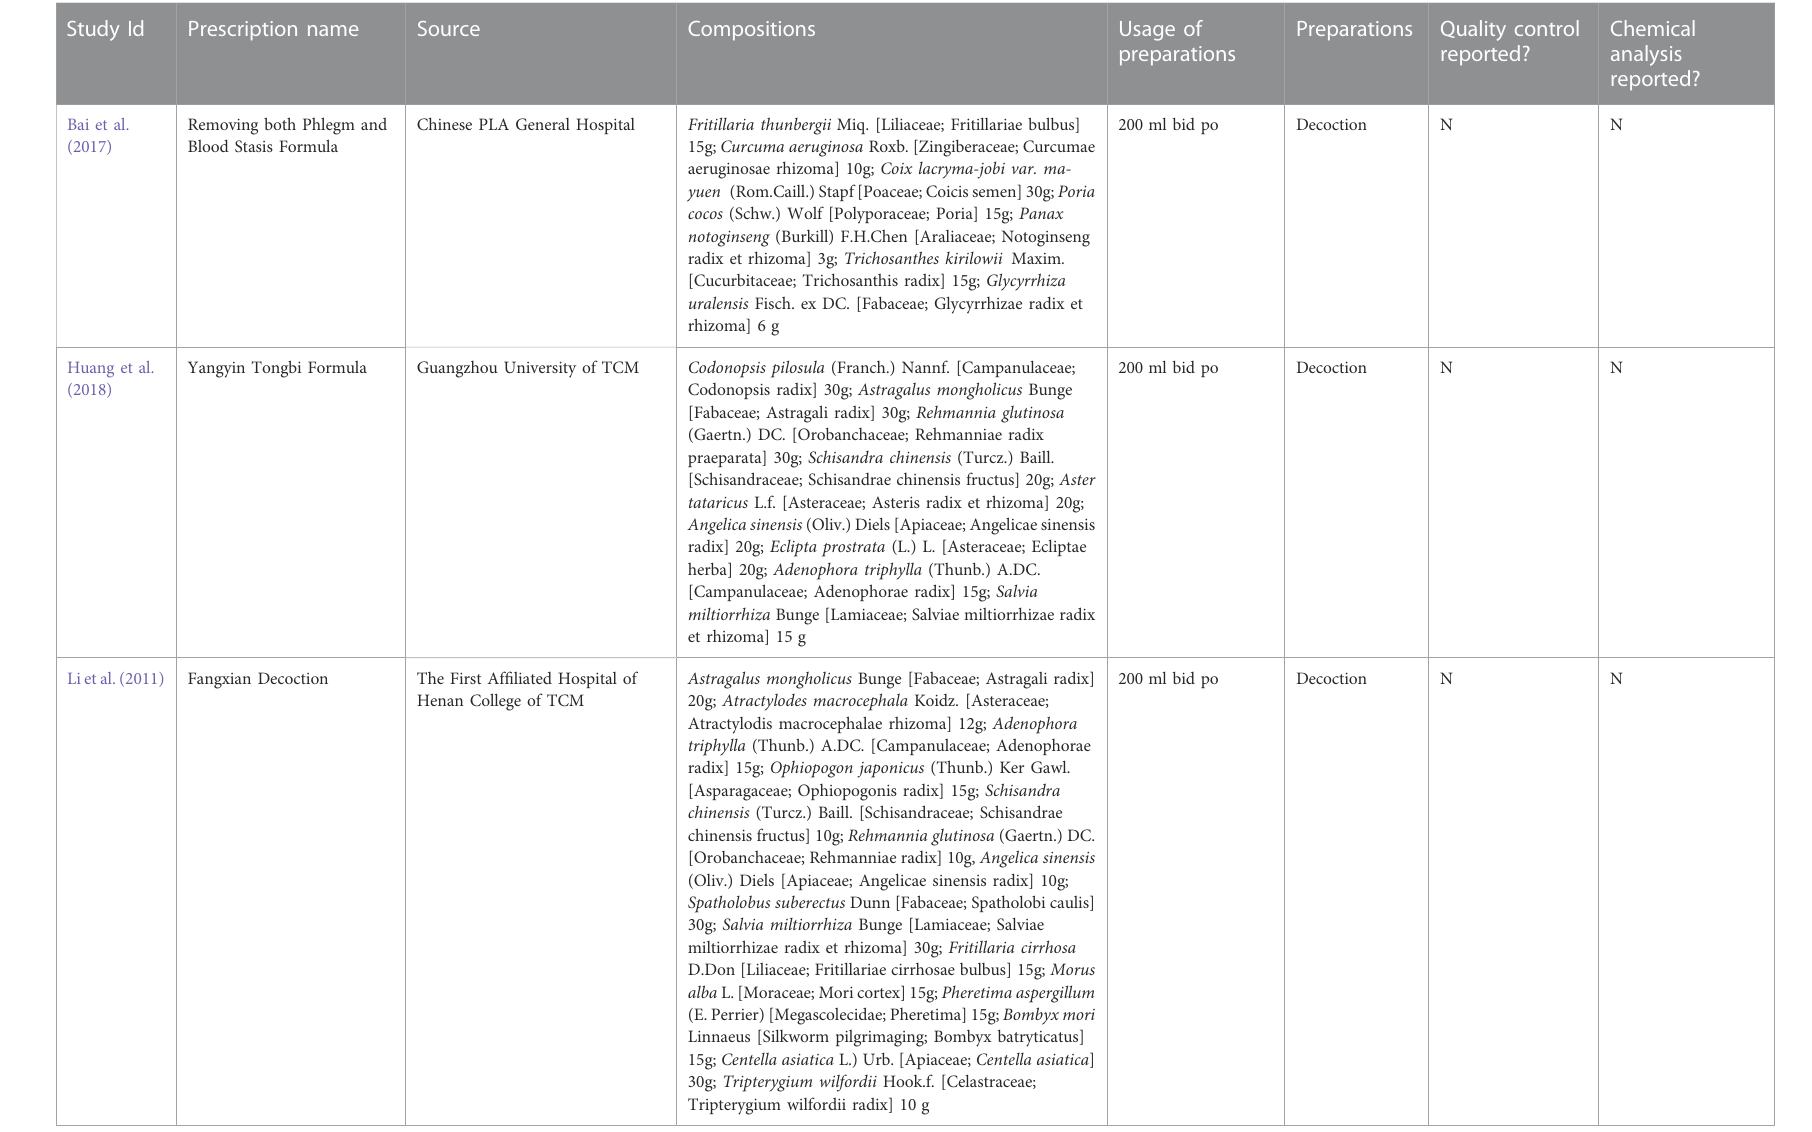
TABLE 2 Components of Chinese herbal medicine used in the included